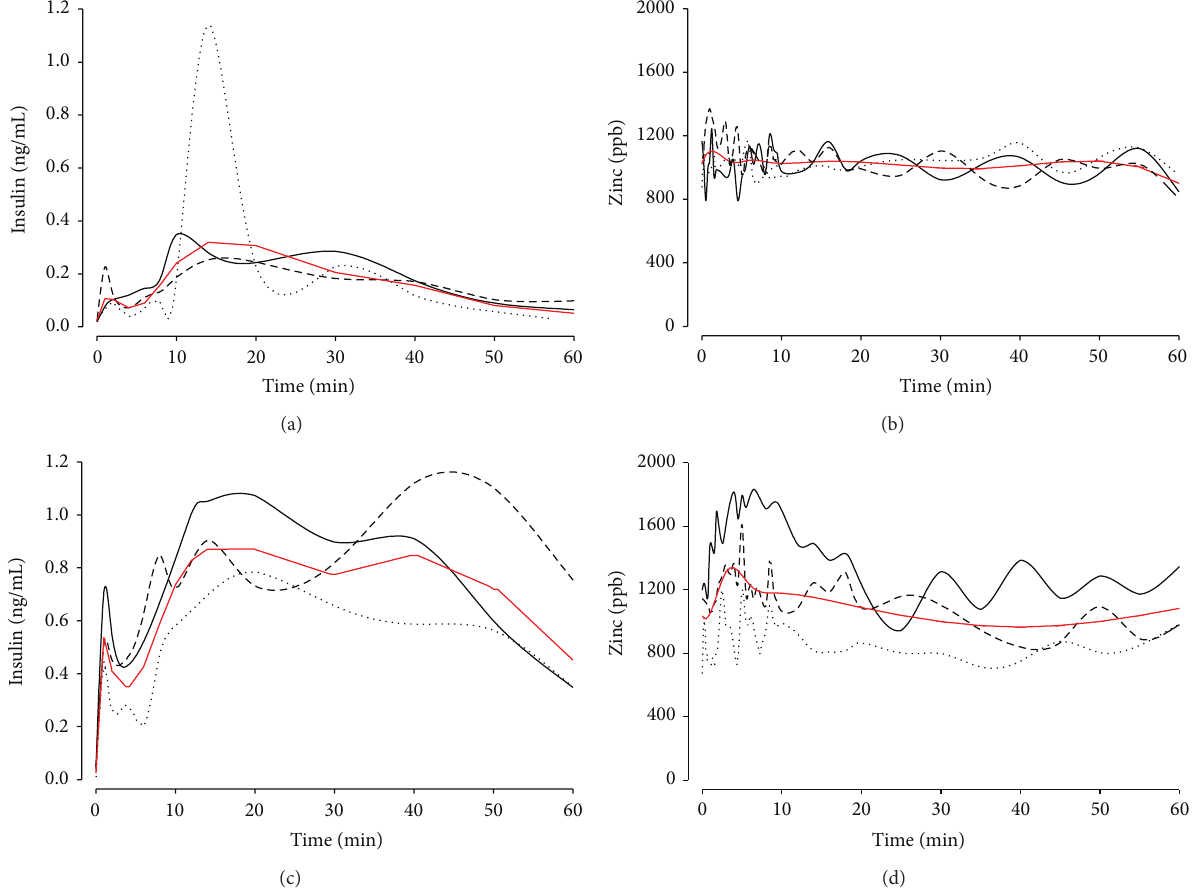
Figure 5: Temporal profile of insulin and zinc concentrations in the portal or splenic blood pool after injection of a dextrose bolus. Three pigs per sampling method are represented by the black dotted, dashed, and solid lines. The red curves shown are spline fits. Top row insulin (a) and zinc (b) release profiles from the transhepatic portal venous sampling technique. Bottom row insulin (c) and zinc (d) release profiles from the transhepatic splenic venous sampling technique. Note the biphasic insulin response with an associated clear rise of zinc concentration after the first peak at approximately 5